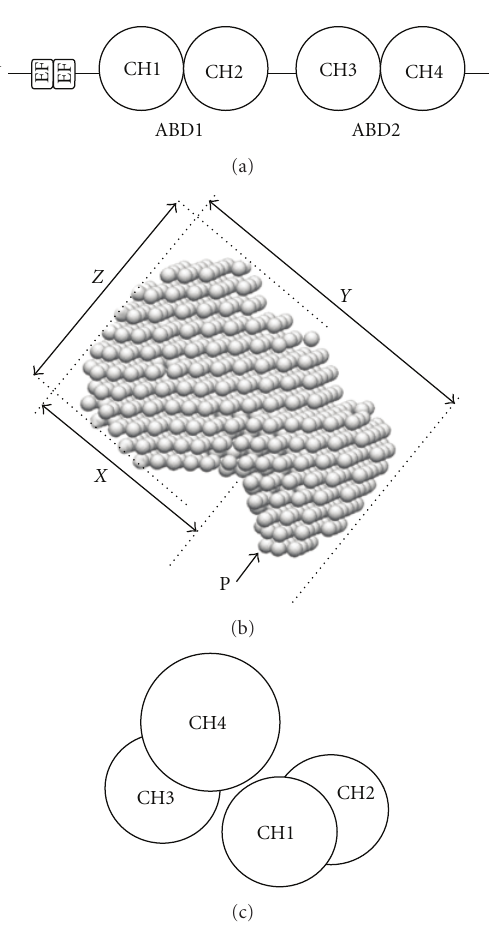
Figure 2: Schematic diagram of L-plastin structure. (a) Domain organization of L-plastin. The protein possesses an N-terminal headpiece of ∼ 100 amino acids containing two EF-hand Ca 2+ - binding motifs and two actin-binding domains (ABDs) consist- ing of ABD1 (residues 120–379) and ABD2 (residues 394–623), and each ABD contains two calponin-homology (CH)